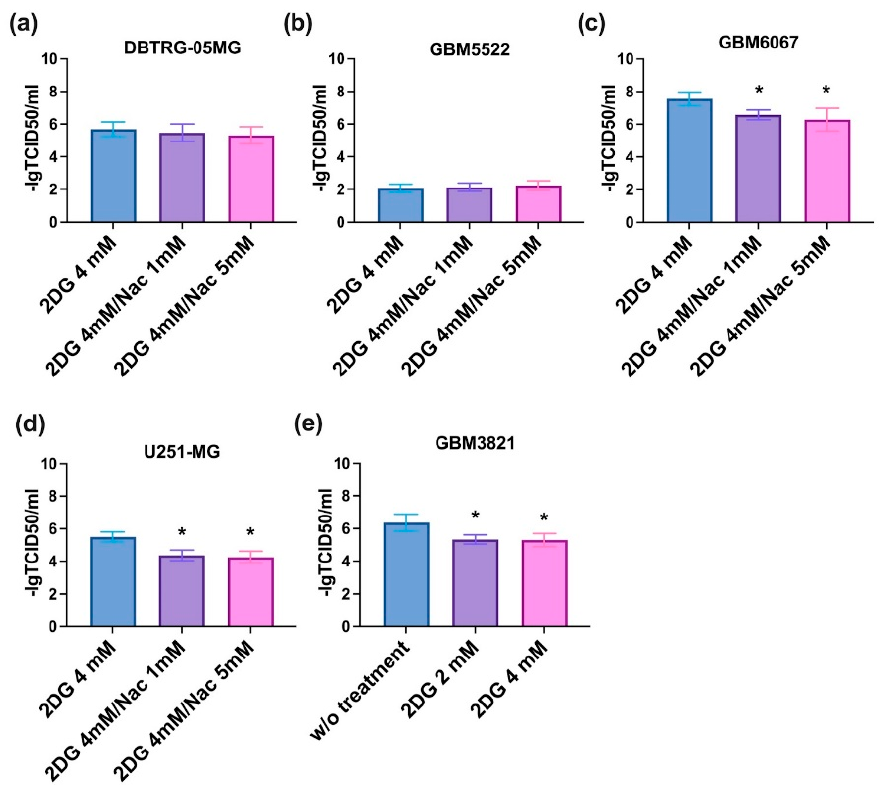
Figure 10. Effect of antioxidant N-acetylcysteine (NAC) on cytopathic effect of CVB5 in the presence of 2DG. DBTRG-05MG ( a ), GBM5522 ( b ), GBM6067 ( c ), U251-MG ( d ) or GBM3821 ( e ) cells were seeded day before treatment with 4 mM 2DG, NAC (1 or 5 mM), and simultaneous infection with CVB5 at MOIs of 0.001-1000. Viability was assessed 48 h post-infection. Values are means ± S.D. * p < 0.05.